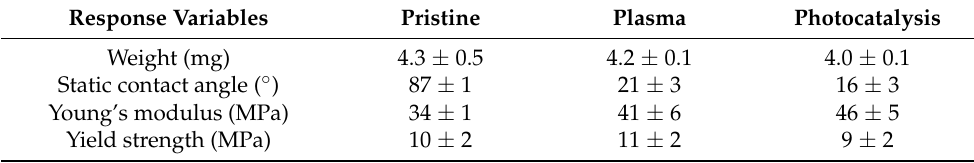
Figure 9. LDPE SEM images after different photocatalytic degradation treatments. ( A – E ) LDPE SEM images after different photocatalytic degradation treatments (2 2 factorial design for 400 h) without analysis. ( A ’– E ’) Same treatments with image analysis. In red, percentage quantification of generated cavities for different treatments. ( A ) Photolysis control. ( B ) T1. ( C ) T2. ( D ) T4 and ( E ) T4 at 400 h. Table 2. Comparison of response variables during sequential plasma-photocatalysis treatment.